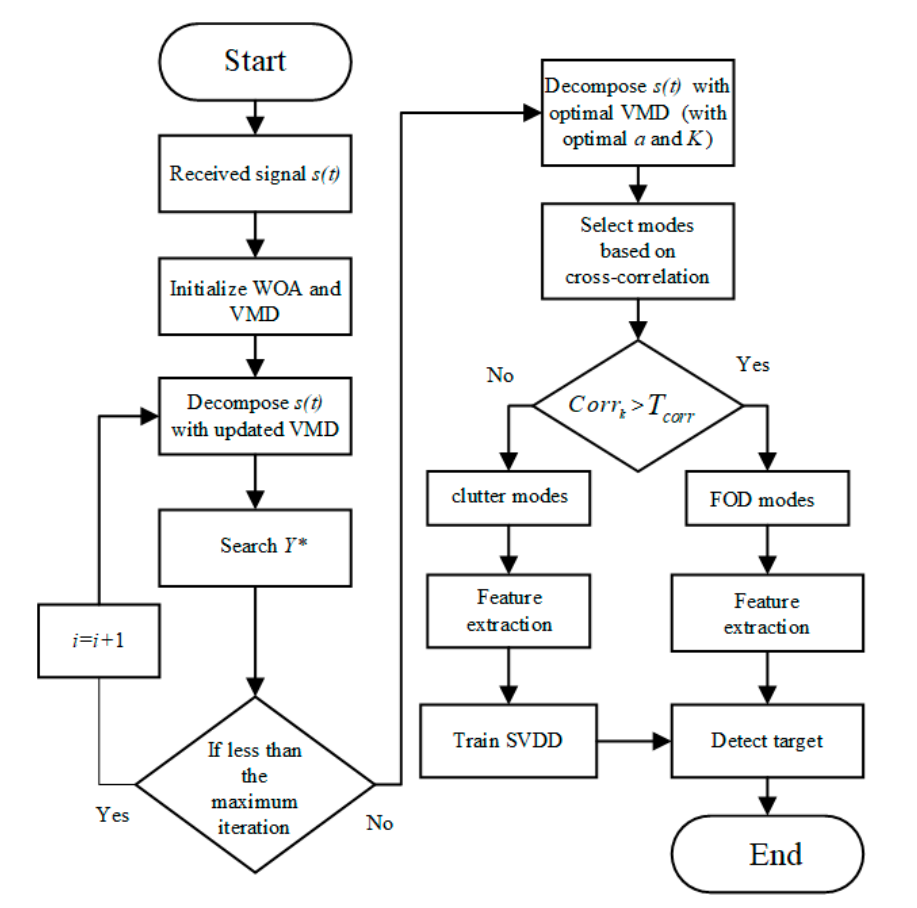
Figure 2. Flowchart of the proposed method.